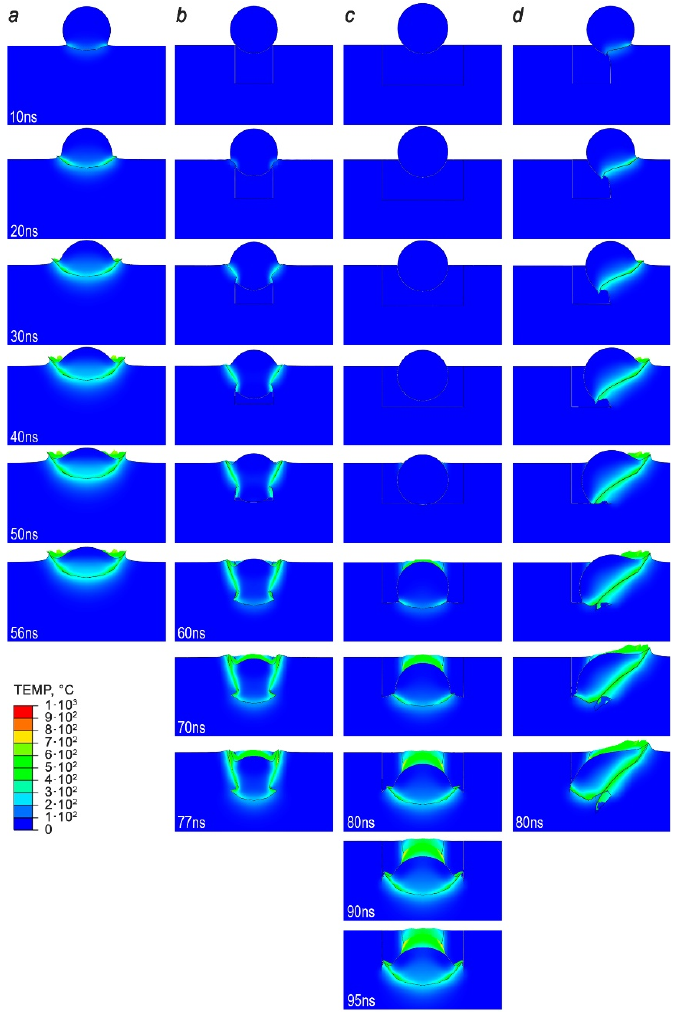
Figure 6. The temperature distribution in the particle ( d P = 50 µ m) and substrate during the collision for four studied cases: ( a ) without microdefect; ( b ) with cube-shaped microdefect; ( c ) with rec- tangular-shaped microdefect; ( d ) with the particle collision on the edge of cube-shaped microdefect.